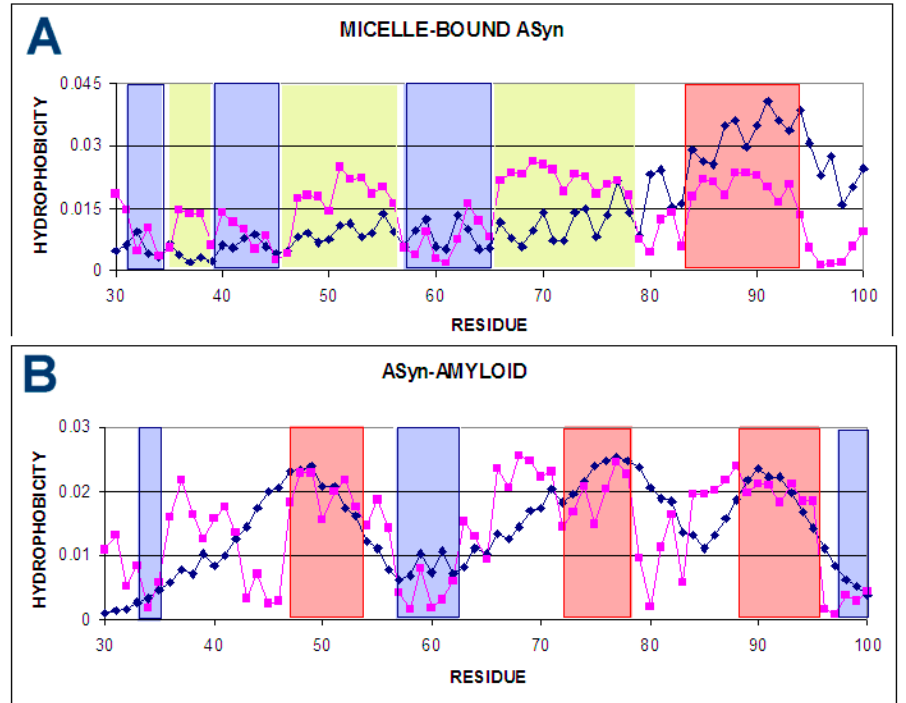
Figure 2. T and O distribution for: ( A ) micelle-bound ASyn (1XQ8); ( B )—status of the chain C as part of the entire fibril (all chains are part of the protein for which 3D Gauss function is generated) (2N0A); the charts represent distributions for the 30–100 segment for all discussed forms. The positions (sections) involved in the construction of the hydrophobic nucleus are marked red. The blue positions—accordant status with low (surface) hydrophobicity level. The yellow segments distinguish the fragments representing evident discordance between expected and observed hydrophobicity level. These fragments are distinguished in 3D presentation in Figure 3.